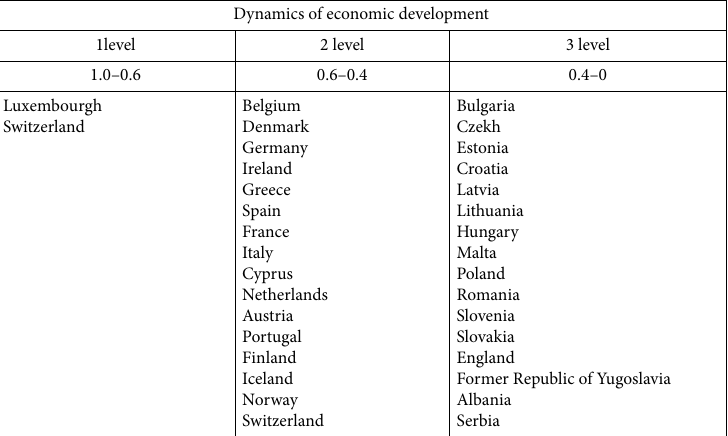
Figure 5. Breakdown of EU countries by the dynamics of economic development over 2008–2017 (source: compiled by